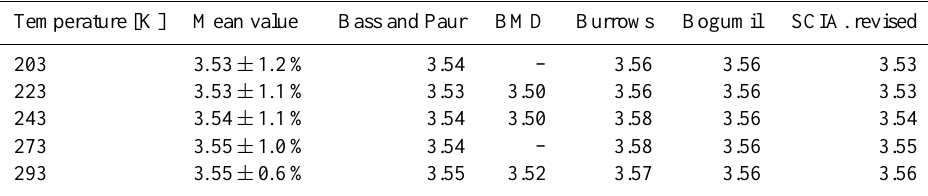
Table 1. Comparison of integrated cross sections in the Hartley band (245–340nm) in units of 10 − 16 cm 2 nmmolecule − 1 . The second column indicates the mean from all available literature as reported in Orphal (2002).